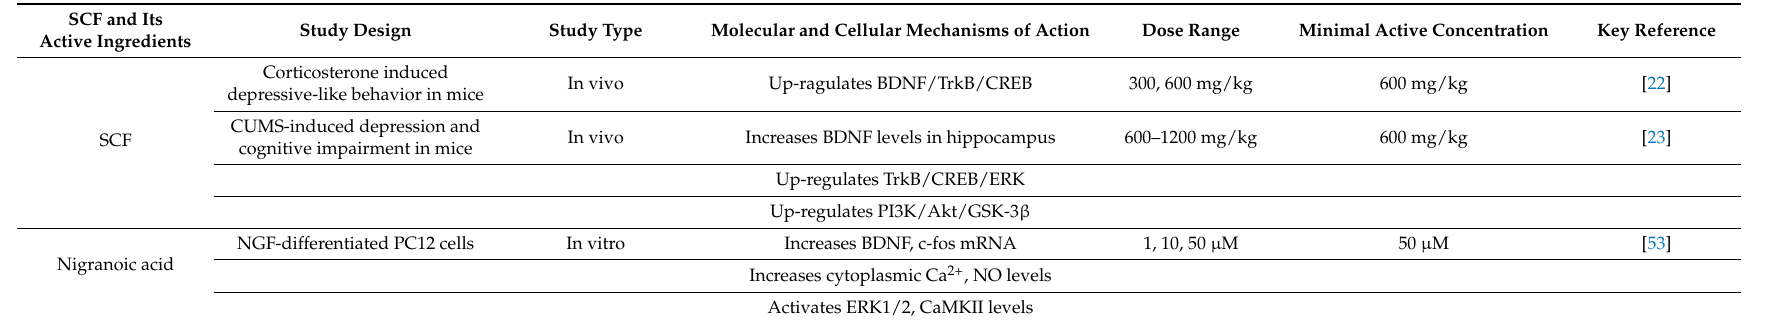
Table 6. The pharmacological data of SCF and its active ingredients in protecting against NDs by modulating BDNF related pathways. CUMS—chronic unpredictable mild